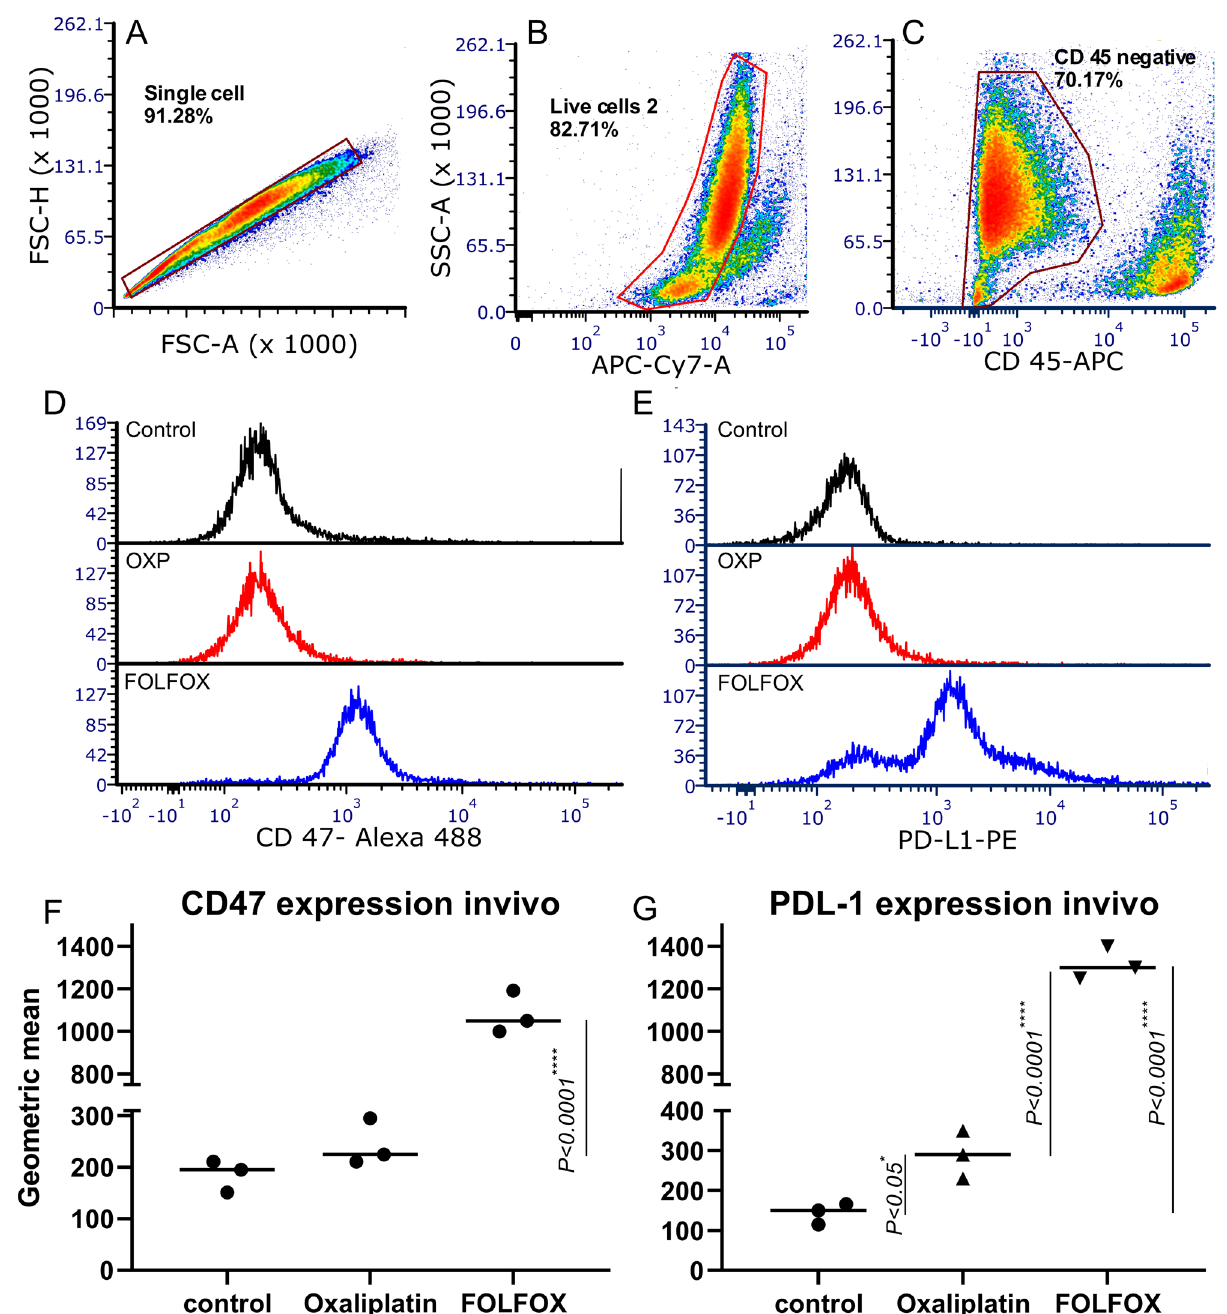
Figure 2. Effect of FOLFOX and OXP on cell surface expression of CD47 and PD-L1 in CT-26 inoculated tumors. ( A – E ) Gating strategies for analysis of CD47 and PD-L1 cell surface expression in CT-26 tumor in mice following treatment with OXP and FOLFOX. ( F ) CT-26 tumor cells were treated with OXP or FOLFOX, and CD47 expression was analyzed by flowcytometry. ( G ) Tumor cells were treated with OXP or FOLFOX, and PD-L1 expression was analyzed by